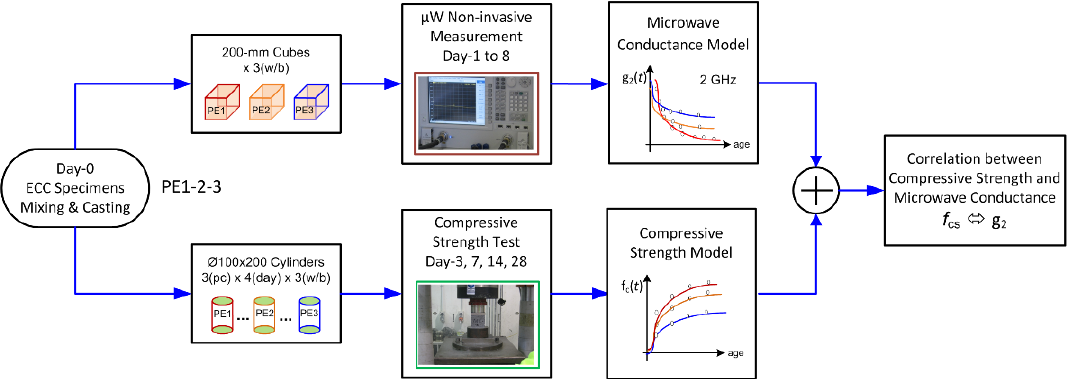
Figure 1. A block diagram illustrating the parallel experimental processes.